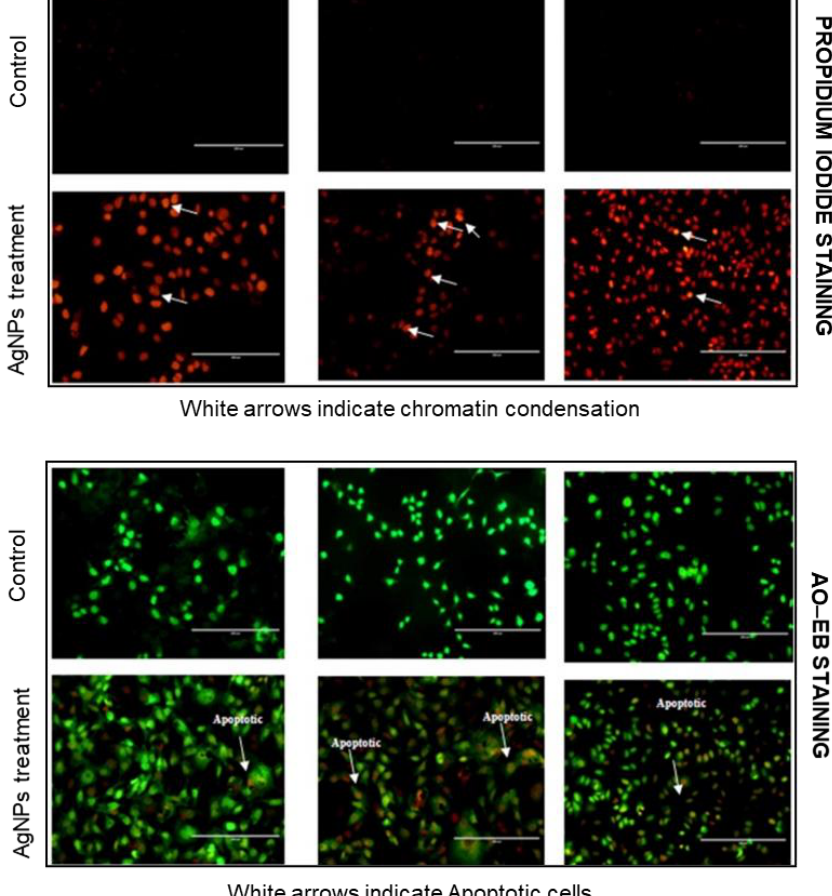
Figure 7. Propidium iodide and Acridine orange-ethidium bromide (AO–EB) staining of the biogenic AgNPs-treated HepG2, A549 and MCF-7 cells.